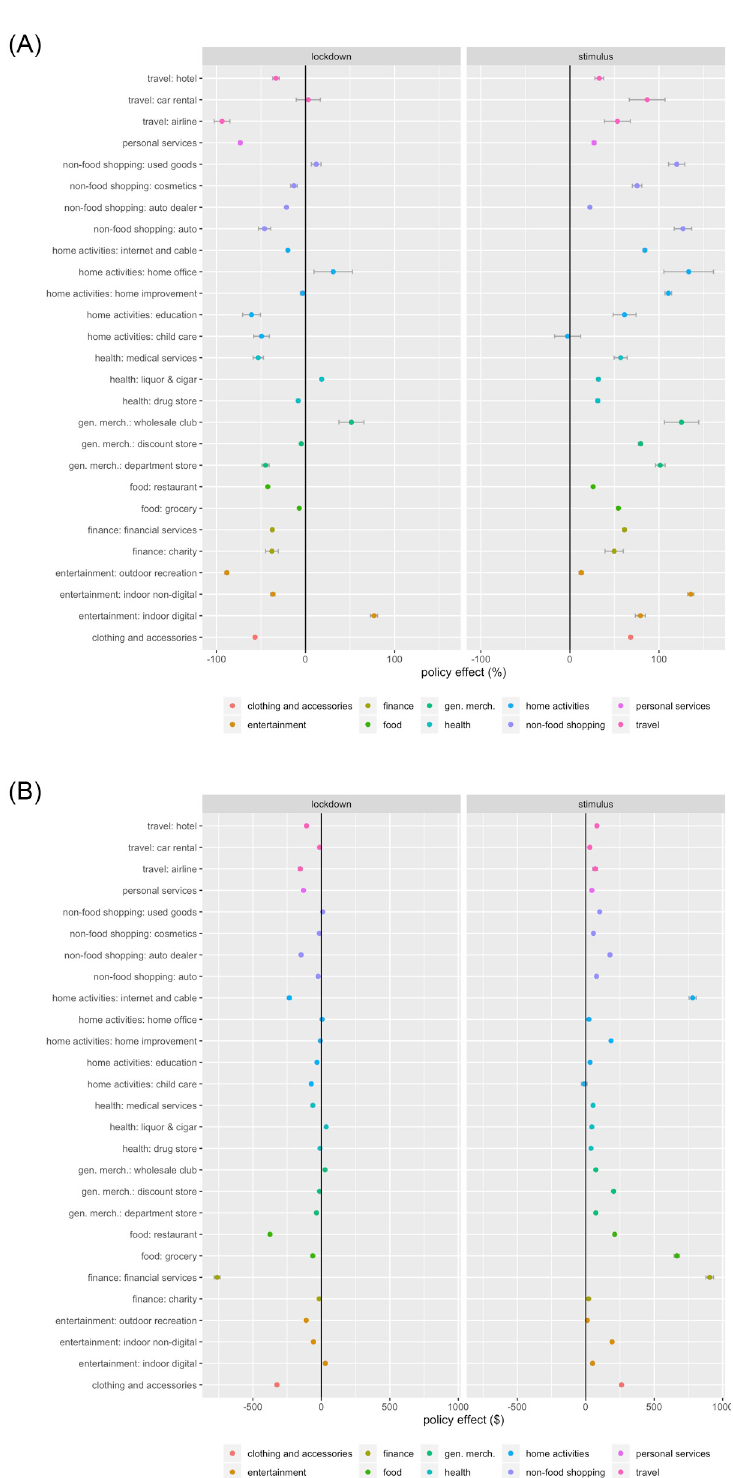
Fig 5. Effects of initial lockdown and stimulus payments by category. (a) Effects on percentage change. (b) Effects on dollar change.